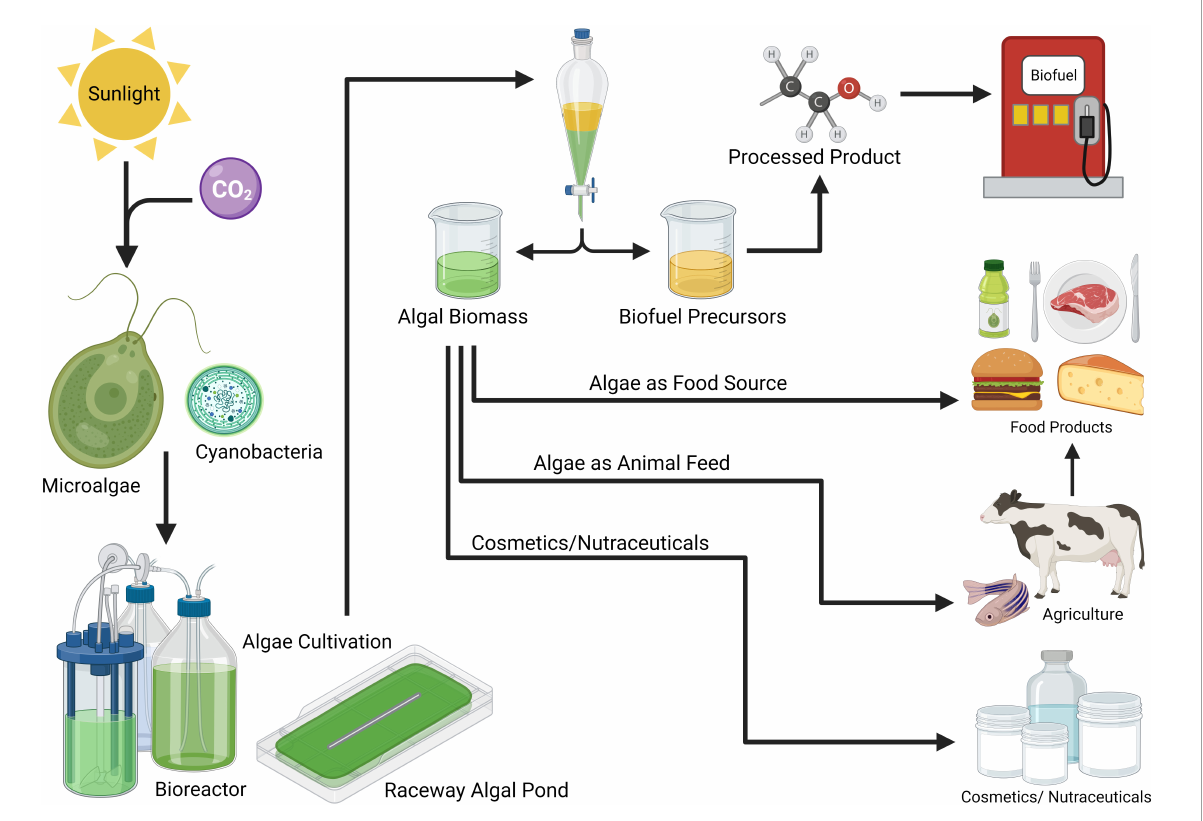
FIGURE1 The versatile markets for algae products (Created with